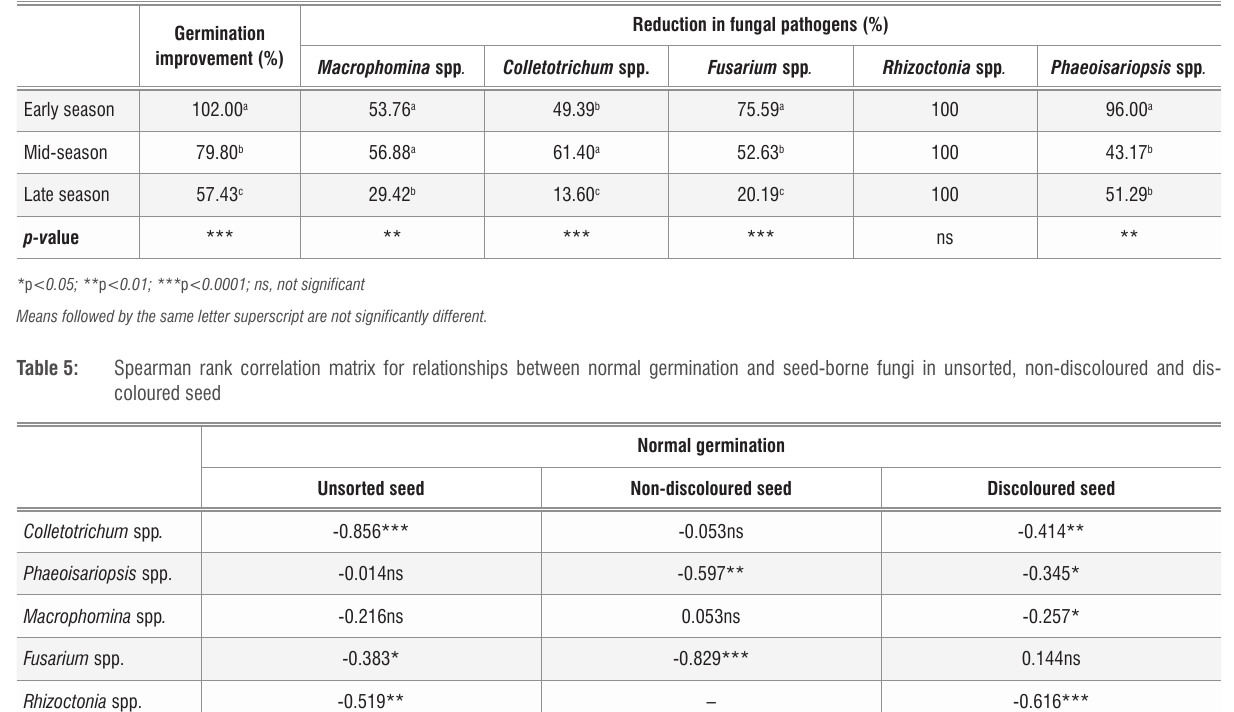
Reduction in fungal pathogens (%)